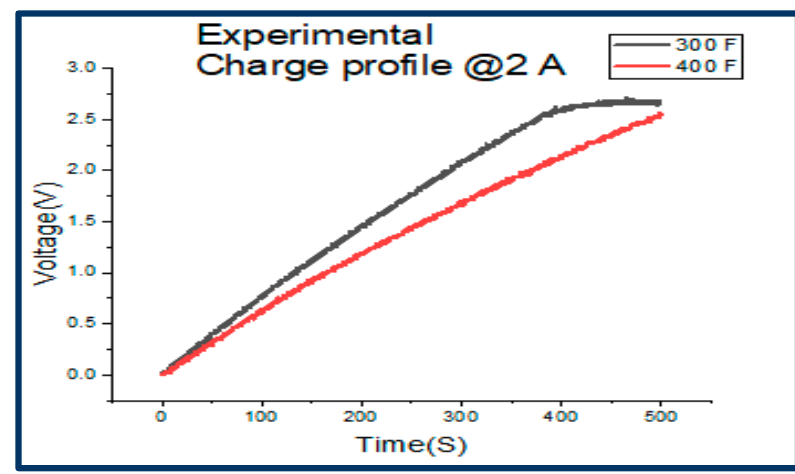
Figure 6. Experimental 300 F and 400 F charge profiles. The charge profile and data obtained during the experiment were used to calculate the parameters/coefficients of the EDLCs two-branch-equivalent circuit. The results for the parameters are shown in Table 3 below.